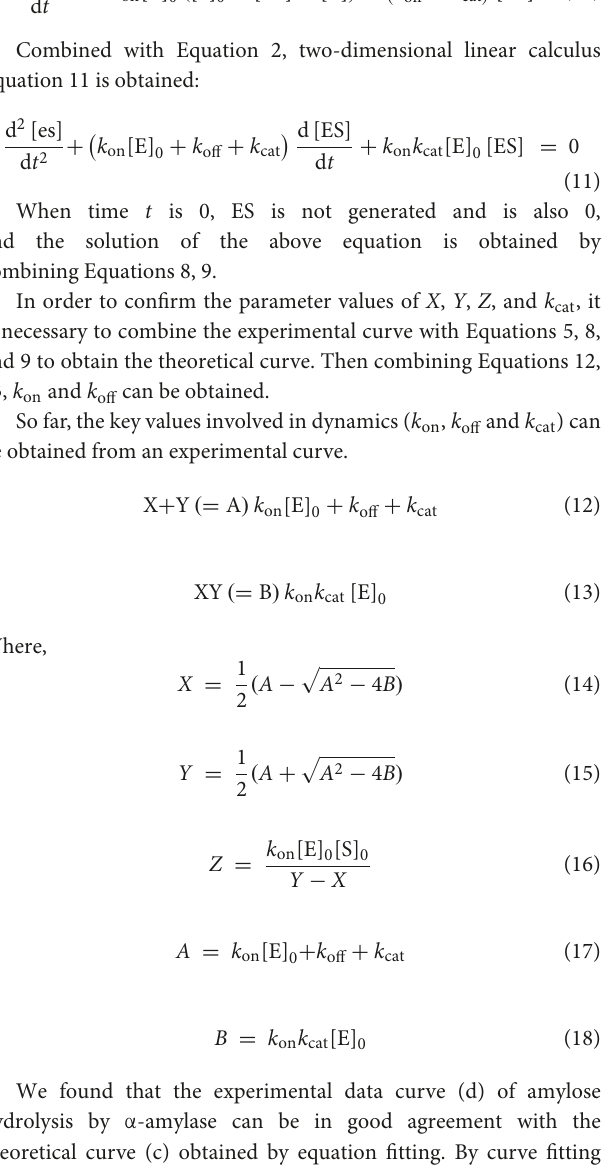
Table 1 . The values of K d and K m ( K d = k off / k on and K m = ( k off + k cat )/ k on ) are also obtained by Equation 4. When the fixed amount of amylose substrate on QCM varied from 20 to 150 ng cm − 2 and the concentration of α -amylase varied from 0.1 to 5 mg mL − 1 , all kinetic parameters ( k on , k off , and k cat ) hardly changed within ± 12% experimental